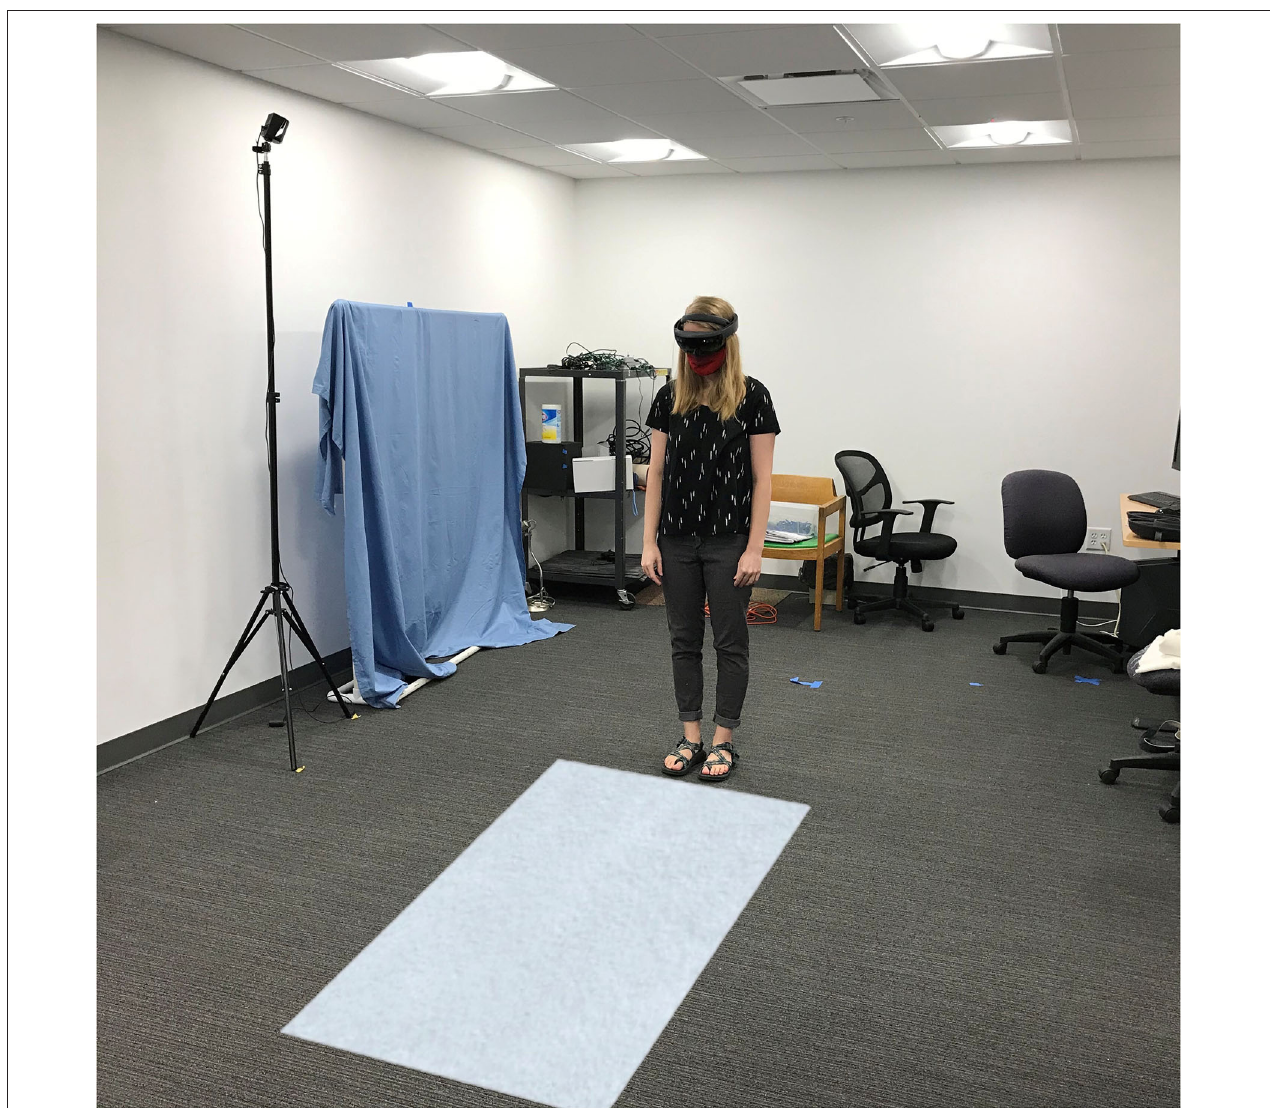
FIGURE 3 | A composite image depicting the AR condition in Experiments 1 and 2 from a third-person point of